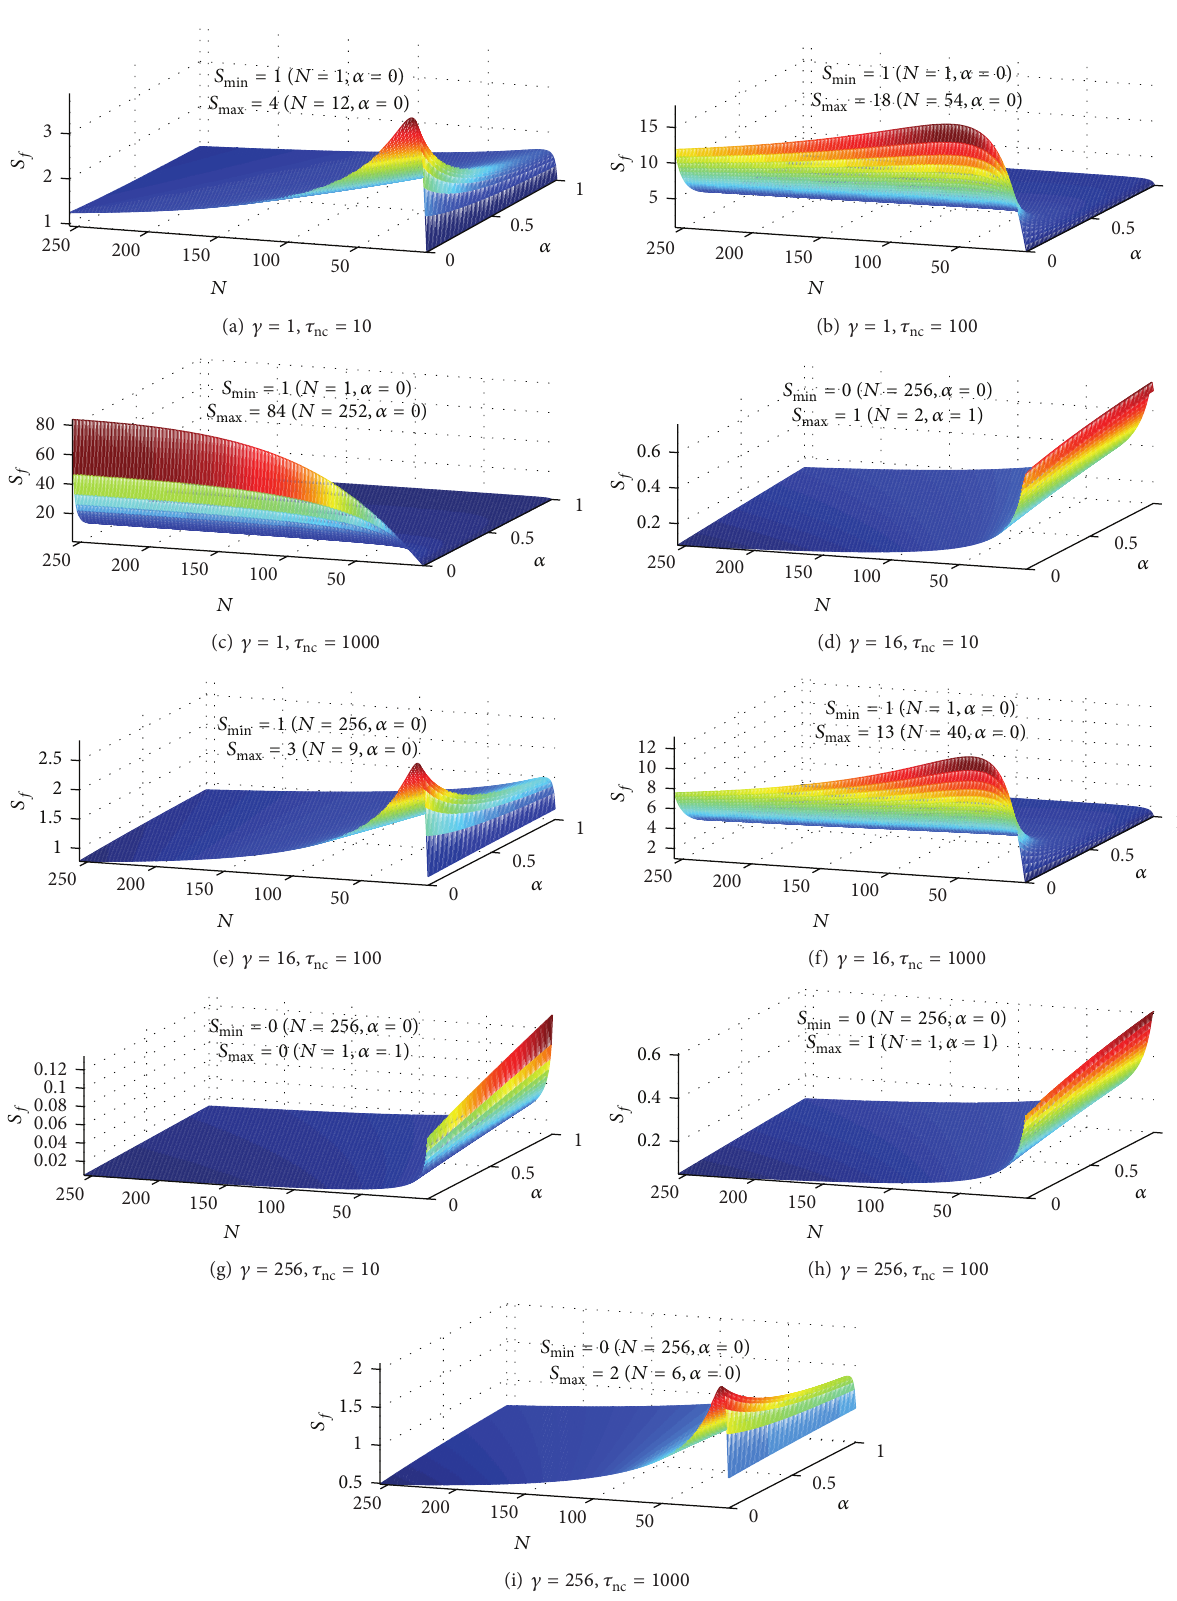
Figure 7: Performance trends under hotspot traffic